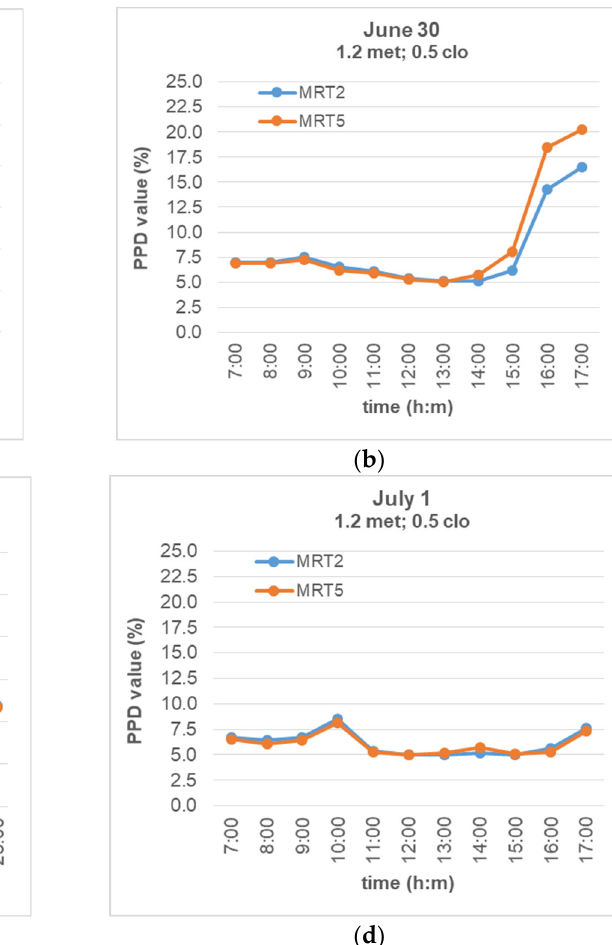
Figure 17. Evaluation of PPD indices from the simulation at different positions of MRT sensors in the room (MRT 5 was the closest to the window and MRT 2 was in the centre of the office): ( a ) PMV on 30 June, ( b ) PPD on 30 June, ( c ) PMV on 1 July, ( d ) PPD on 1 July.